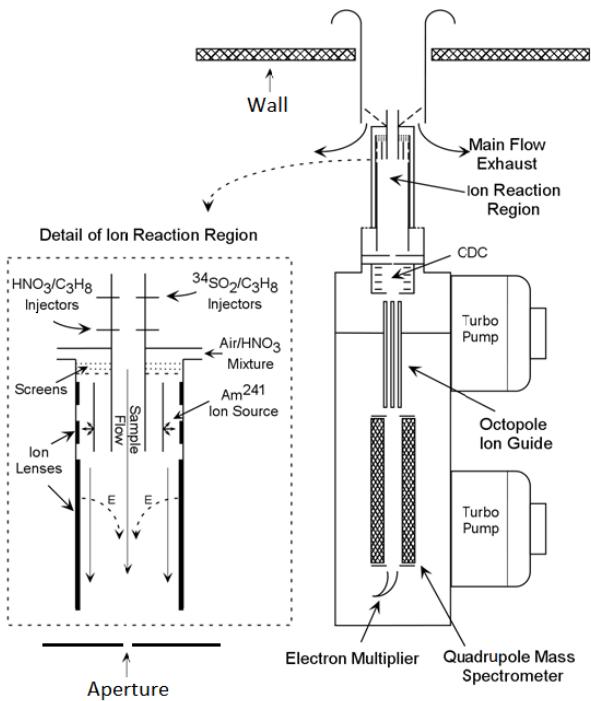
Figure 1. Principle scheme of SI/CIMS components including air inlet (modified from R. L. Mauldin III, personal communication, 2012). Inset shows details of the atmospheric pressure region, with reagent gas flows indicated for measurement of OH background sig- nal (both 34 SO 2 and C 3 H 8 are added to the sample air through the two front injectors; see text). Laminar flow conditions with a cen- tral flow axis velocity of 0.71ms − 1 in both the sample and ion- ization tubes are generated by a 12slpm sample flow, 58slpm total flow (i.e., sample flow plus sheath flow, the latter indicated here by addition of an Air/HNO 3 mixture), and the geometries of the sam- ple tube (diameter 1.9cm) and ionization tube (diameter 4.2cm). The time needed (in each case starting at the first injector) to reach the second injector is 73ms, to the entrance of the ionization re- gion 115ms, and to the aperture in front of the mass spectrometer